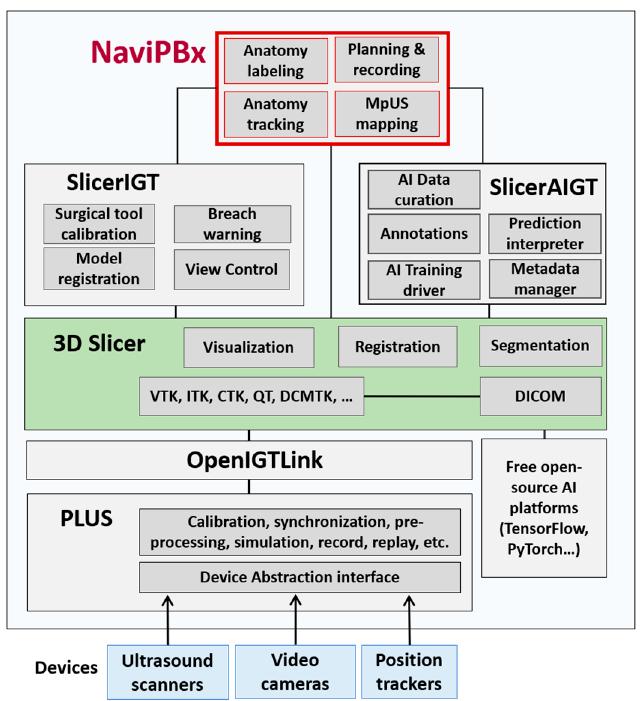
Figure 2. Software system architecture for the NaviPBx prostate biopsy system.